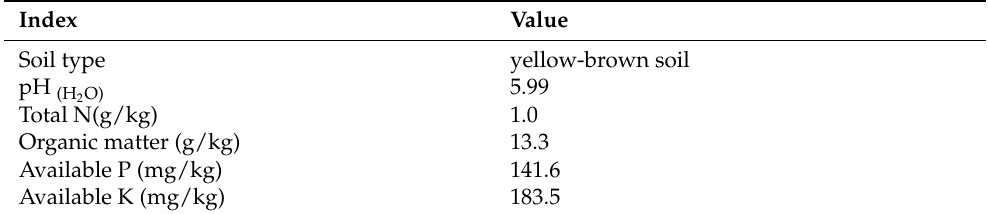
Table 2. The physicochemical properties of